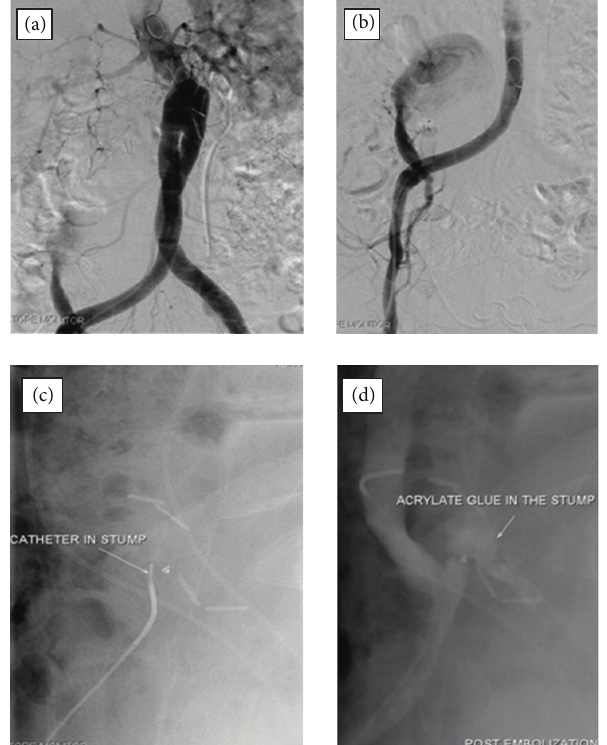
Figure 2: (a) Aortogram shows pooling of the leaked contrast agent from the distal anastomosis. (b) Image obtained with tip of the microcatheter positioned at the ostium of the pseudoaneurysm (arrow). (c, d) Acrylate glue seen within the pseudoaneurysm on postembolization image